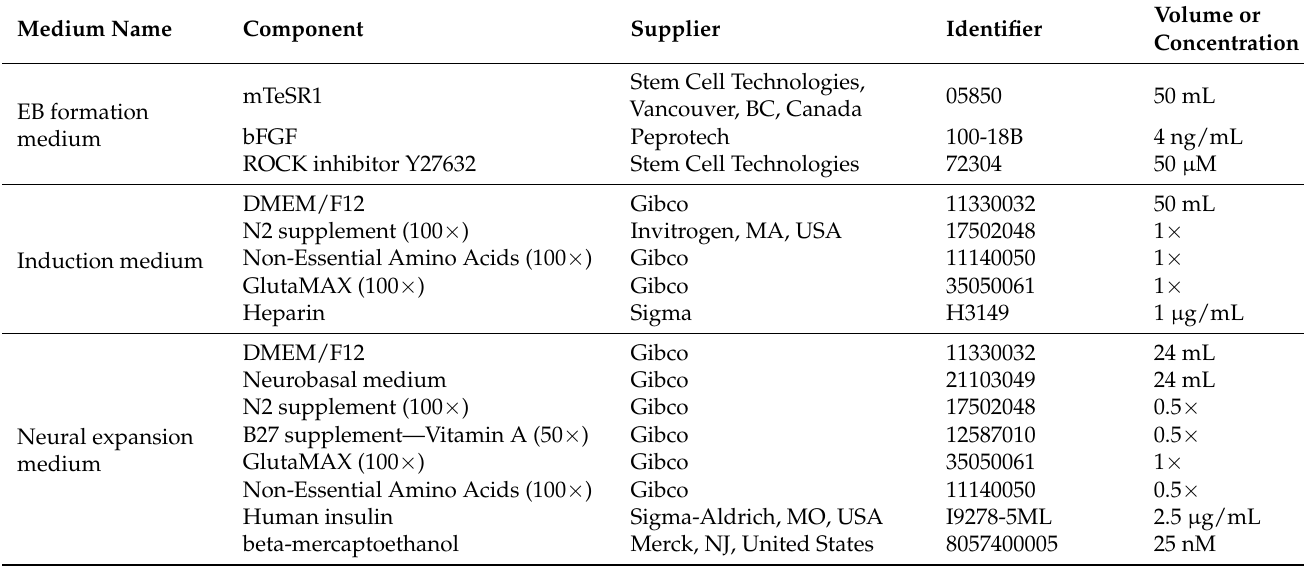
Table 1. Composition of Cerebral organoid differentiation